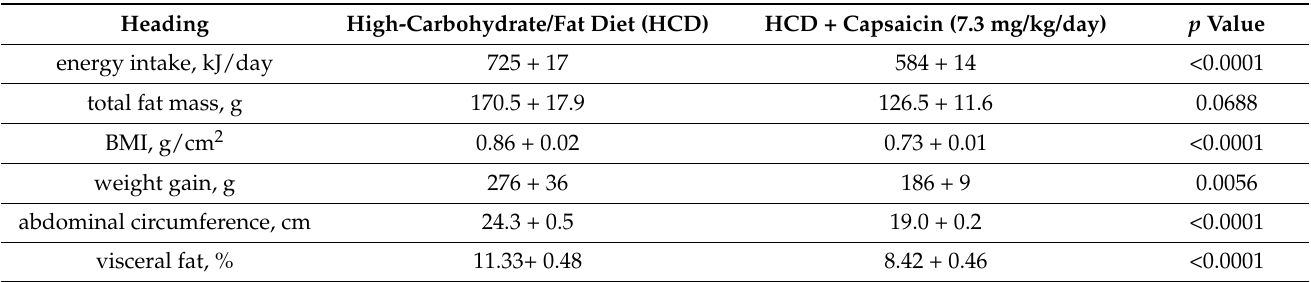
Table 1. Effect of dietary capsaicin (7.3 mg/kg body weight/day) administered for 16 weeks on body composition changes induced by high-carbohydrate/high-fat diet. Data are from [38].